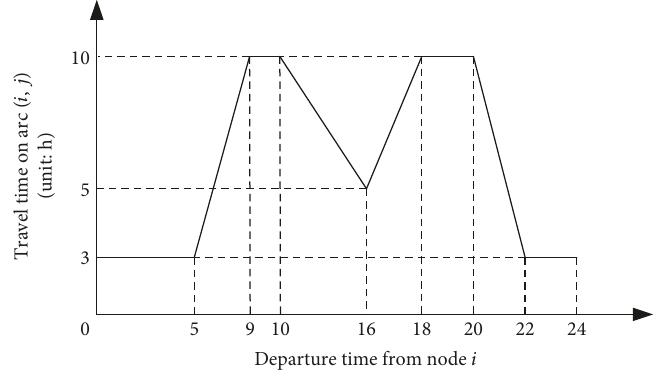
Figure 3: Time-dependent travel time formulated by piecewise linear